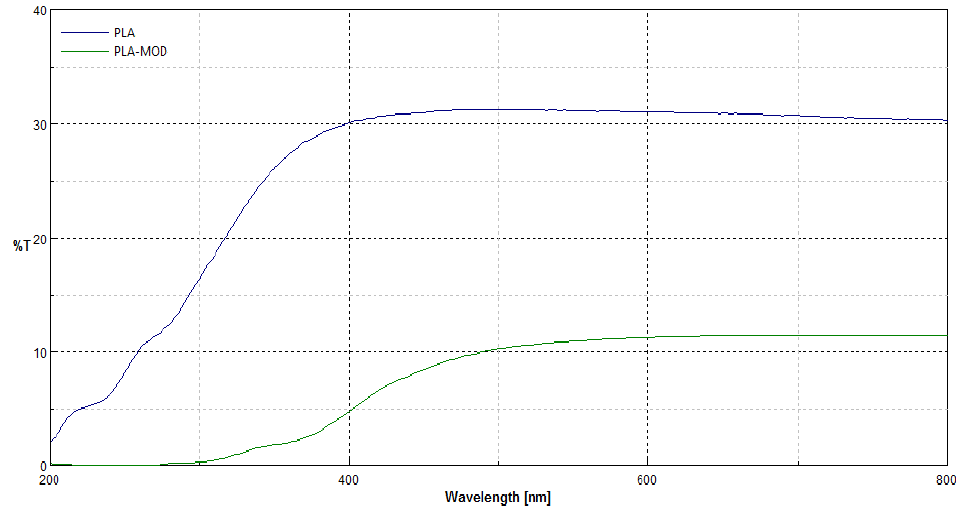
Figure 7. Comparison of transmittance spectra [%T] of polylactide nonwoven samples without (PLA) and with Fosfomycin coating (PLA-MOD) in the range λ = 200 – 800 nm.